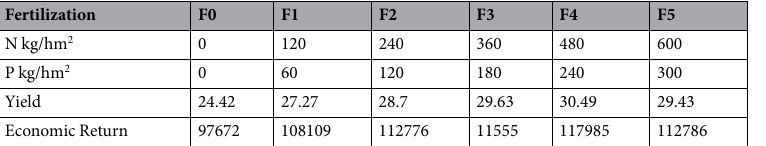
Table 1. Economic returns from apple orchards under different fertilization treatments in Luochuan.